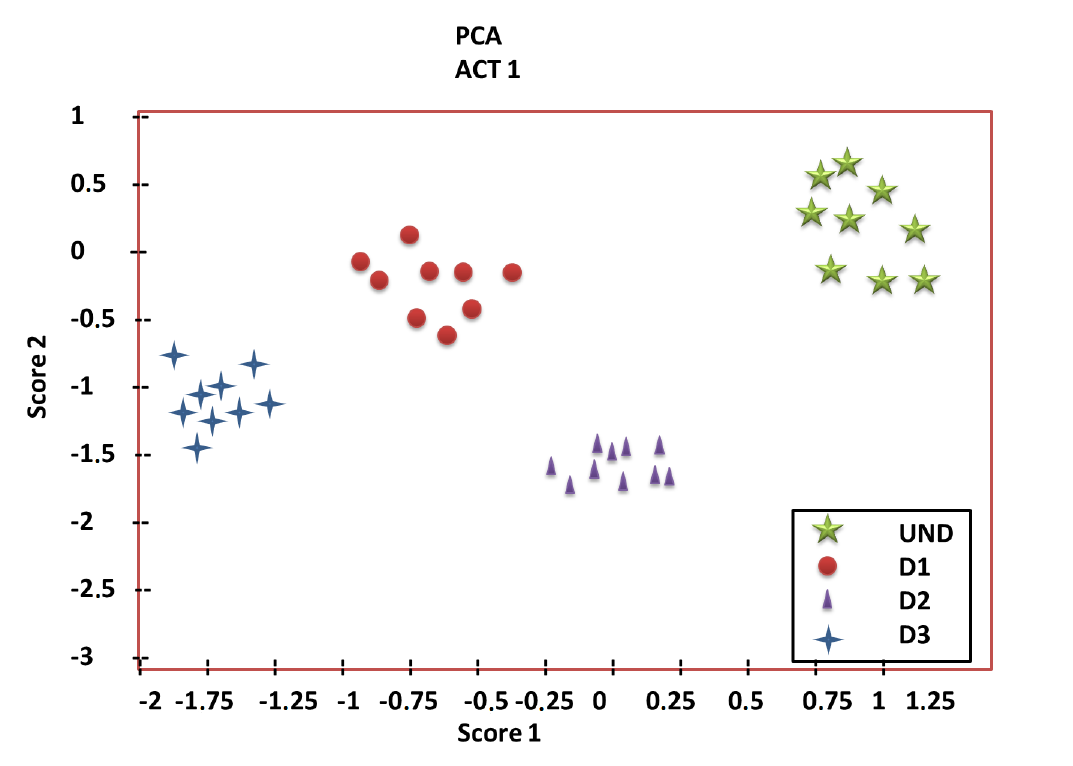
Figure 5. Score 1 versus Score